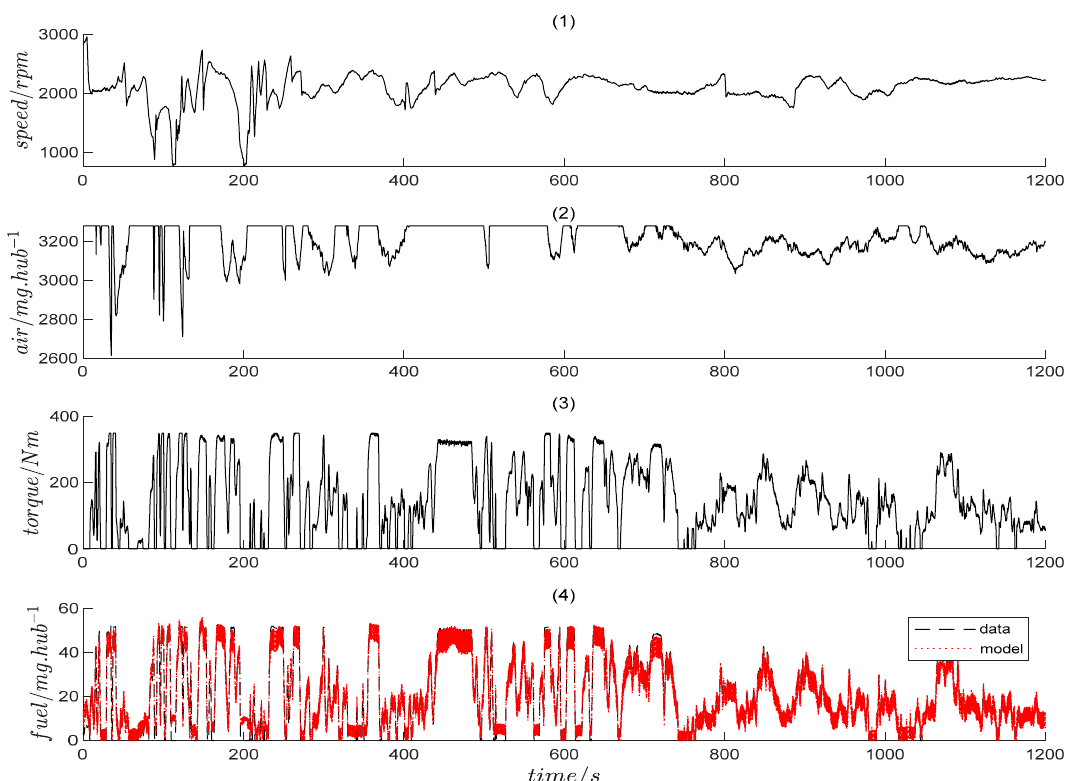
Figure 4. External characteristics of the CA4D28C5 diesel engine. The solid lines represent equal fuel consumption (g/kwh) contours.